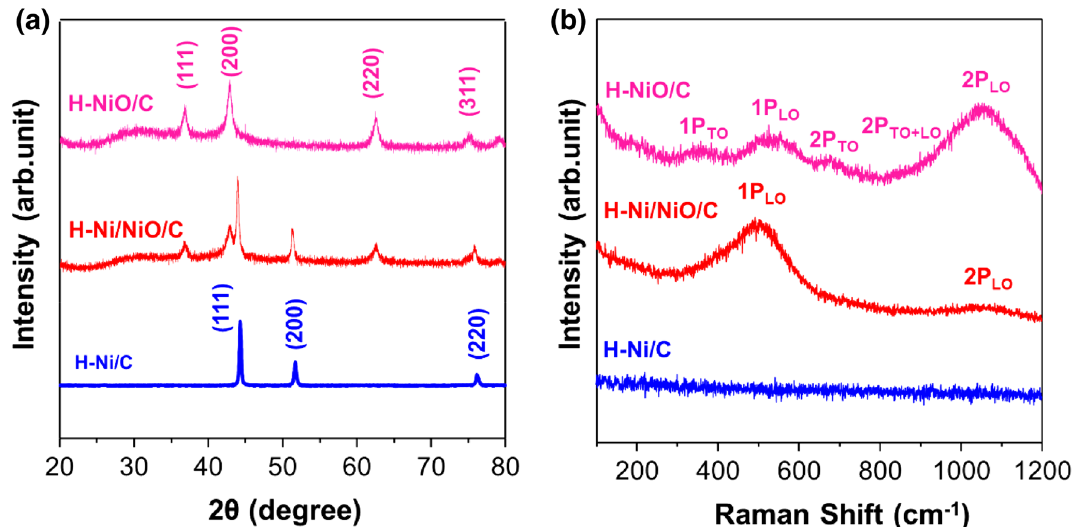
Fig. 3 a XRD patterns and b Raman spectrum of H–Ni/C, H–Ni/NiO/C, and